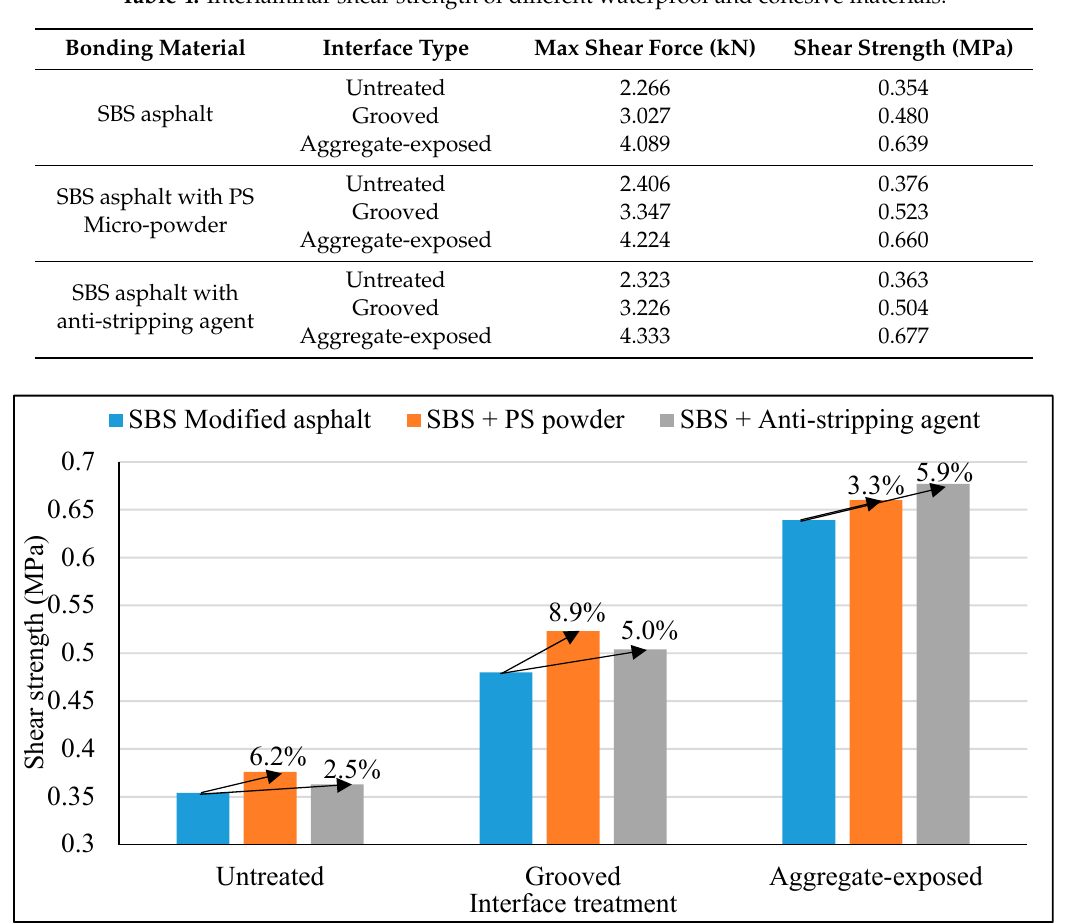
Table 5. Test results of interlaminar shear strength under different normal pressures.